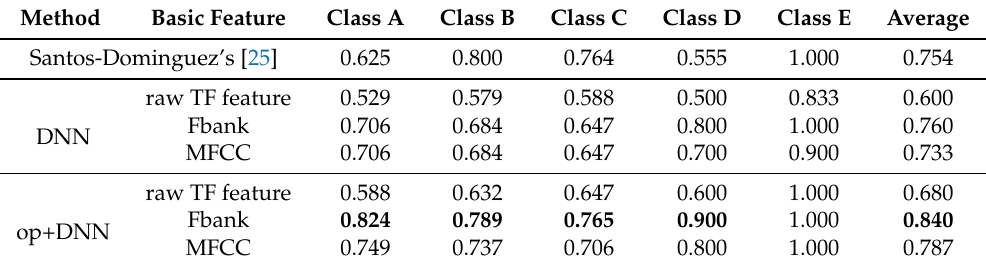
The accuracy comparison on Shipsear dataset among Santos–Dominguez’s, DNN, and op+DNN, op+DNN means using optimization model and DNN classification